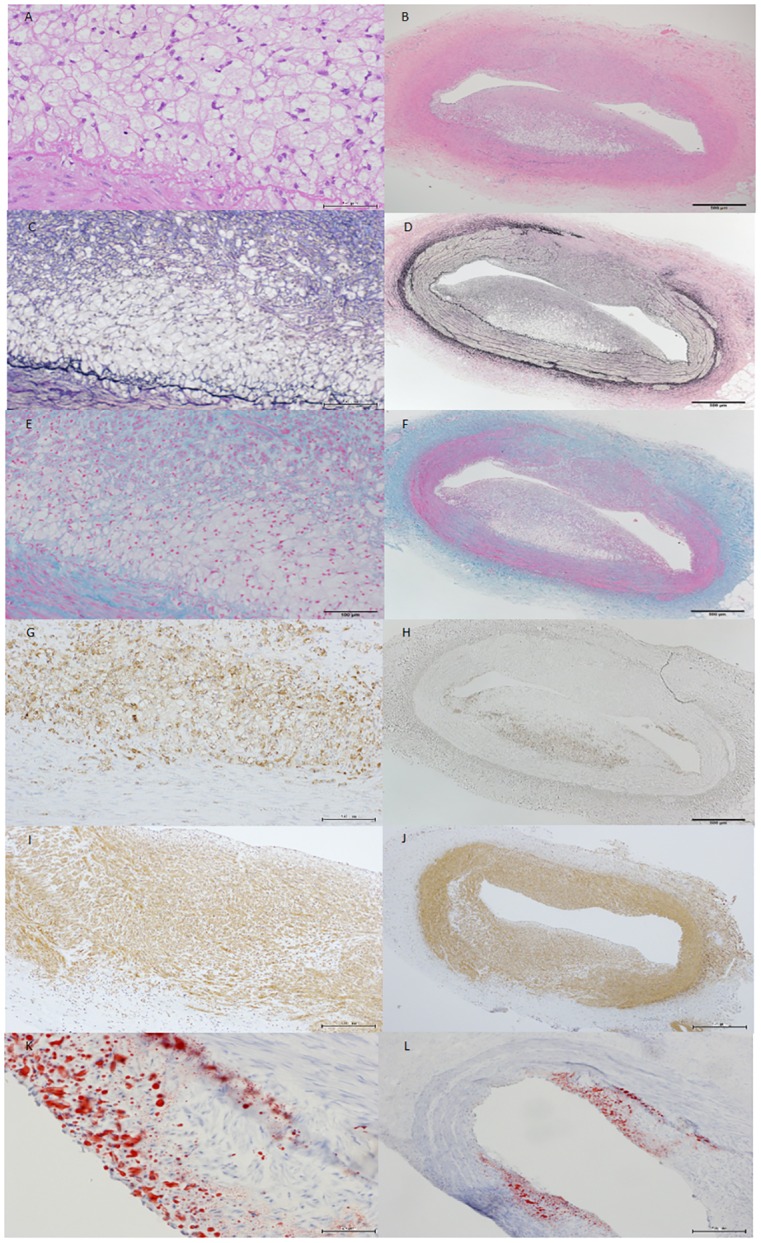
(A-L): Coronary arterial lesion in LDLR-KO pig at eight weeks.Eccentric coronary plaque with considerable macrophage infiltration and foam cells indicates increased lesion complexity. A and B, hematoxylin-eosin; C and D, Elastica van Gieson; E and F, Azan; H and E, cathepsin S immunohistochemical staining; I and J, alpha smooth muscle actin immunohistochemical staining; K and L, oil red staing. Scale bar, 100 μm on the left panel and 500 μm on the right panel.